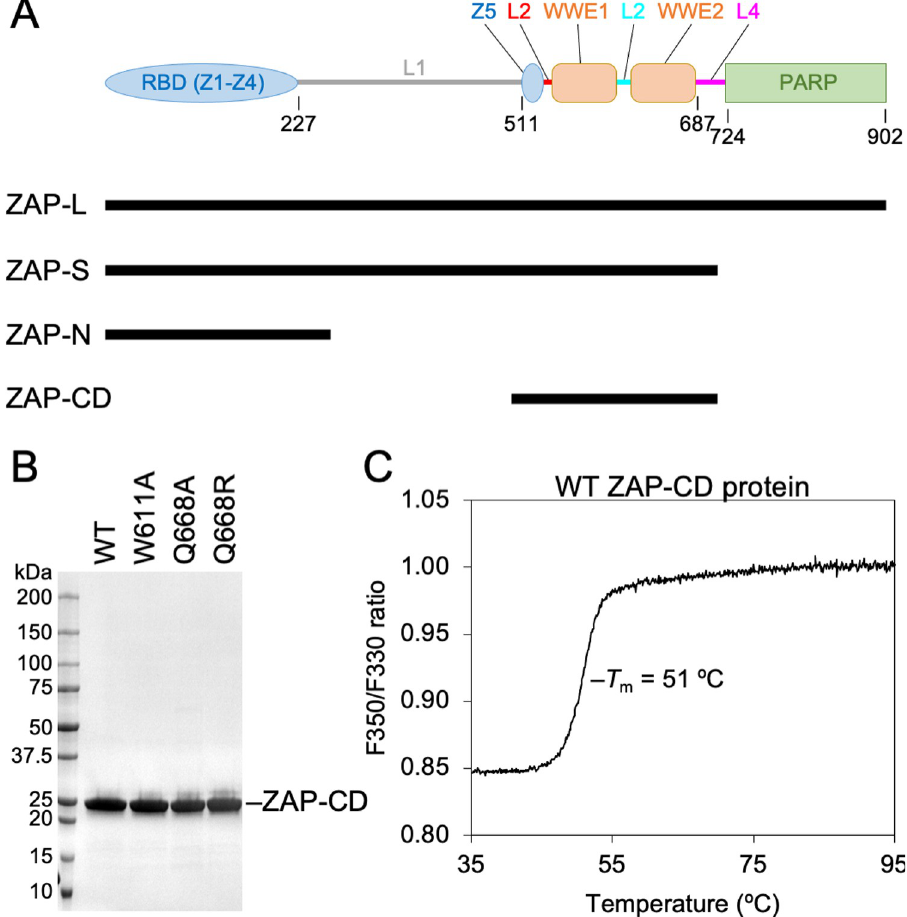
Fig 1. Modular domain organization of ZAP. (A) Domain diagram of the ZAP primary sequence. Modules are colored according to their structural properties (zinc fingers Z1, Z2, Z3, Z4 and Z5 in blue; WWE1 and WWE2 domains in orange; PARP in green; inter-domain linkers L1, L2, L3, and L4 in gray, red, cyan and magenta). Indicated below are the two major naturally-occurring splice isoforms (ZAP-L and ZAP-S), the minimally active antiviral fragment (ZAP-N), and the central domain described in this study (ZAP-CD). (B) SDS-PAGE profiles of purified recombinant ZAP-CD proteins used in this study. (C) Differential scanning fluorimetry profile of wild type (WT) ZAP-CD shows a single transition. The apparent melting temperature ( T m ) is 50.9 ± 0.1˚C, determined with five independent protein preparations.